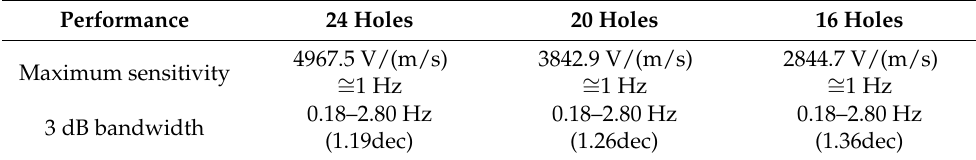
Table 1. Performance comparisons of electrochemical seismometers with 24, 20 and 16 flow holes. Performance 24